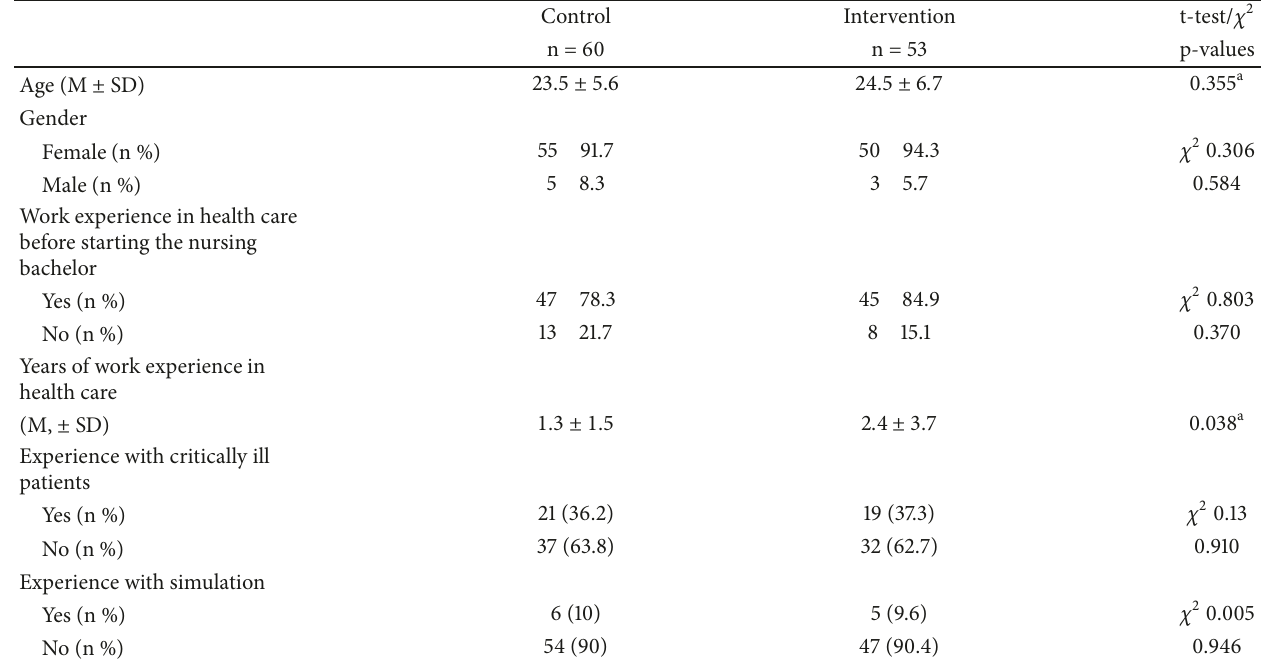
Table 3: Characteristics of the